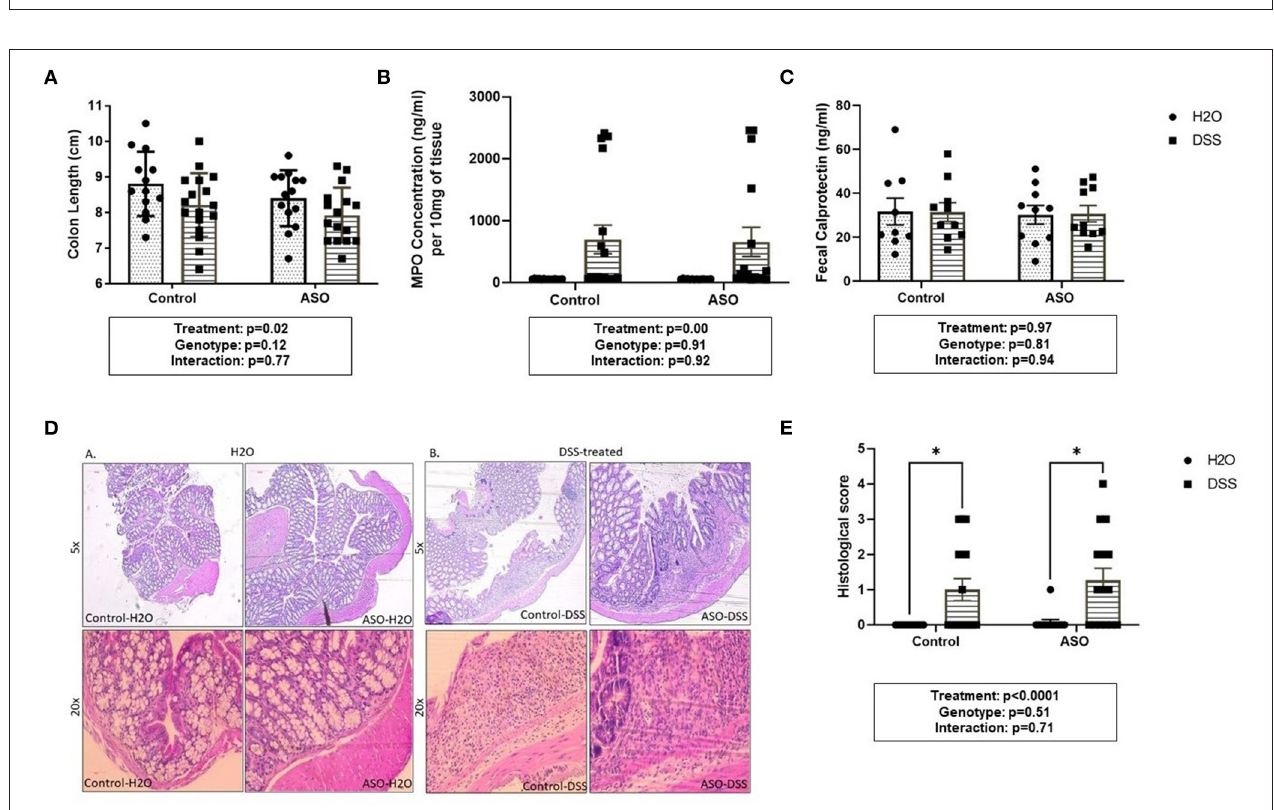
mice treated with DSS. Outliers were omitted prior to analysis ( > 2 standard deviations from the mean). Two-way ANOVA was conducted and values for different factors are indicated in the graphs followed by post-hoc Tukey which is indicated on each graph when appropriate * p < 0.05. ASO, α -synuclein overexpressing; W/H 2 O, water; DSS, dextran sodium sulfate.